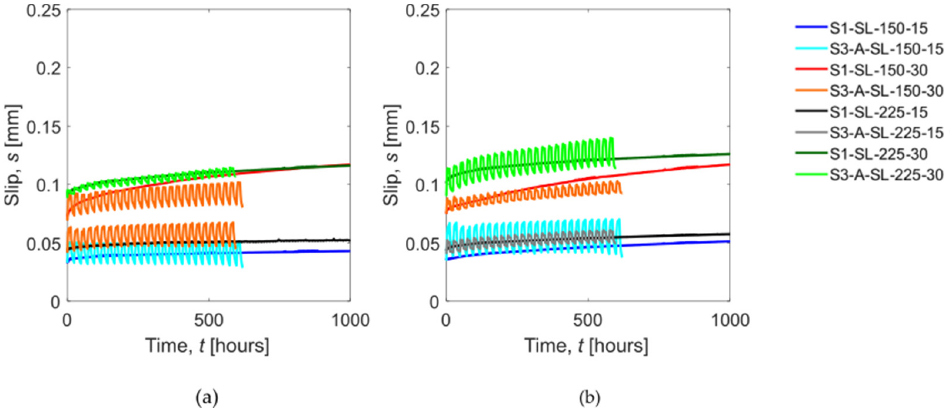
Figure 5. Comparison of the slip evolution with time obtained in series S1 and S3 ‐ A for groove thicknesses of: ( a ) 7.5 mm; ( b ) 10 mm.